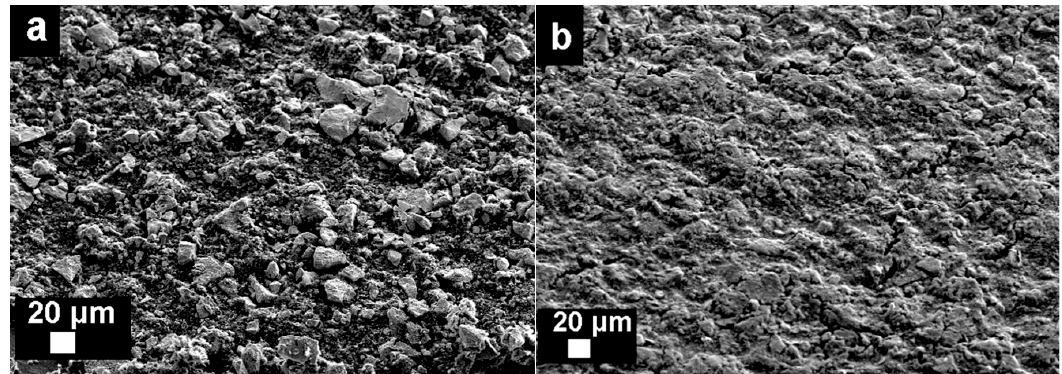
Figure 1. SEM images of freshly prepared electrodes: ( a ) LMO PVDF ; and ( b ) LMO PEDOT:PSS / CMC (our data from Ref. [66]).